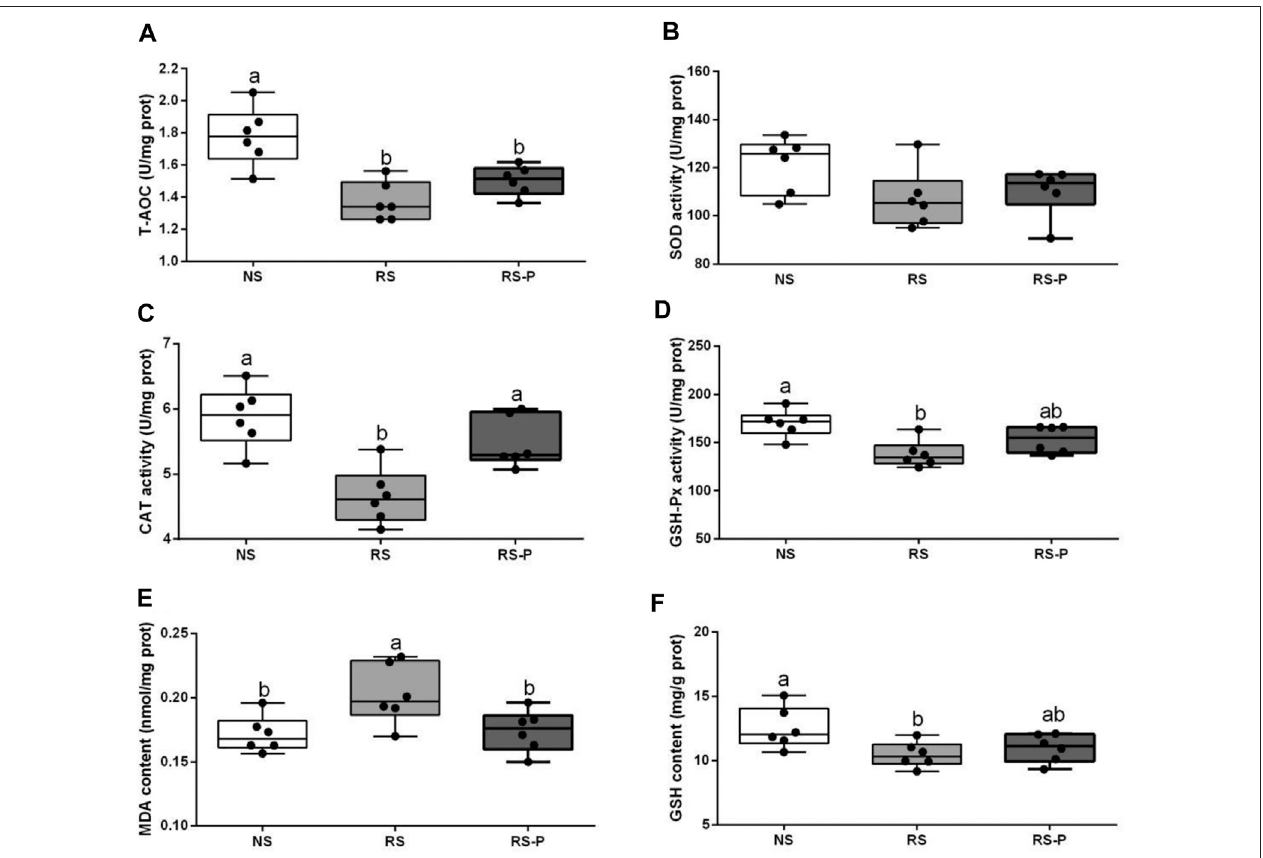
FIGURE 8 | Antioxidant indexes in the hippocampus. Data are presented with the means ± standard deviation ( n (cid:2) 6). Bars with different letters are signi fi cantly differenton thebasisofDuncan ’ smultiple range test ( P < 0.05). (A) – (F) :Activitiesor contentsofT-AOC, SOD,CAT, GSH-Px, MDA and GSH, respectively. T-AOC, total antioxidation capacity; SOD, superoxide dismutase; CAT, catalase; GSH-Px, glutathione peroxidase; MDA, malondialdehyde; GSH, glutathion.